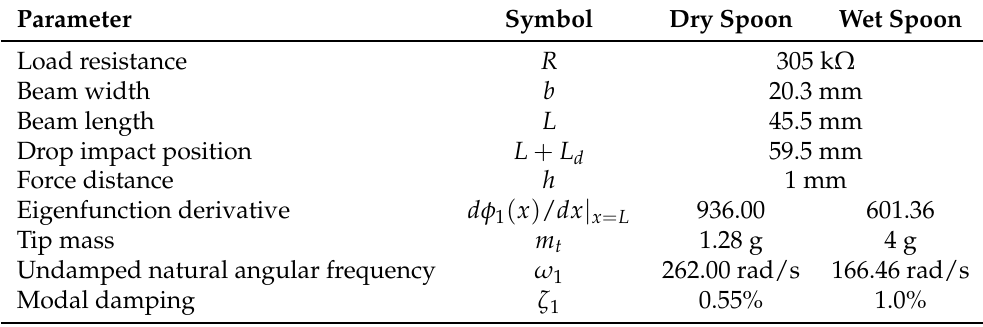
Table 1. Model parameters.